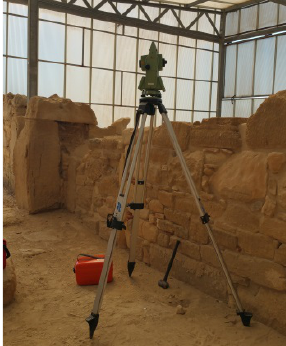
Figure 4. Topographic survey with total station Leica TCR 307.